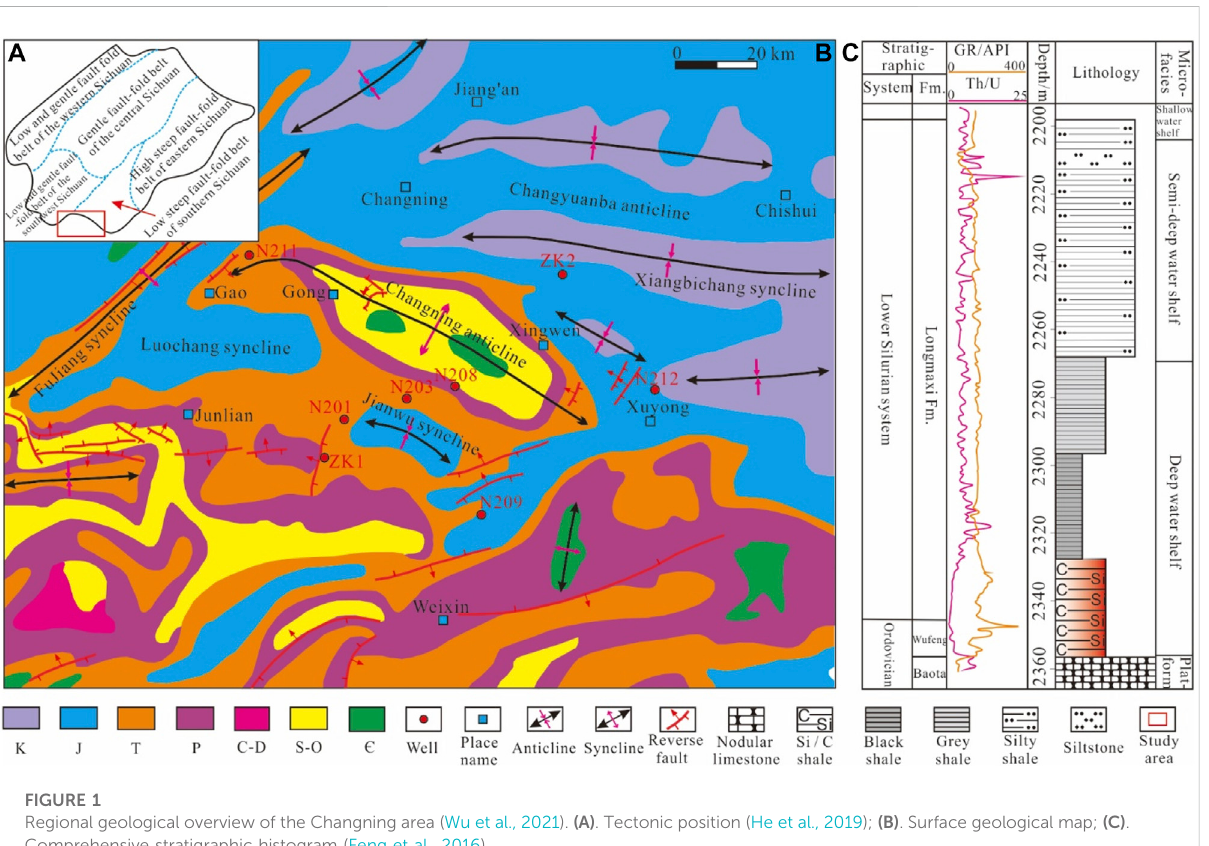
FIGURE 1 Regional geological overview of the Changning area (Wu et al., 2021). (A) . Tectonic position (He et al., 2019); (B) . Surface geological map; (C) . Comprehensive stratigraphic histogram (Feng et al.,